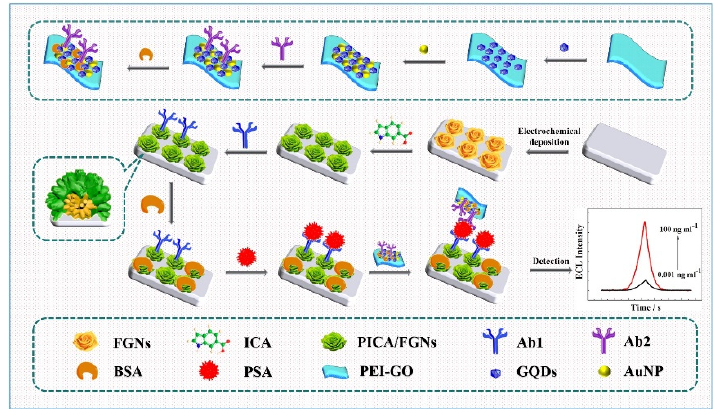
Figure 8. Examples of ECL immunosensors with covalently immobilized capture antibodies. The capture antibodies were chemically immobilized on a PICA–AuNP nanocomposite-modified electrode using EDC/NHS. Reproduced with permission [110]. Copyright (2020) Elsevier.